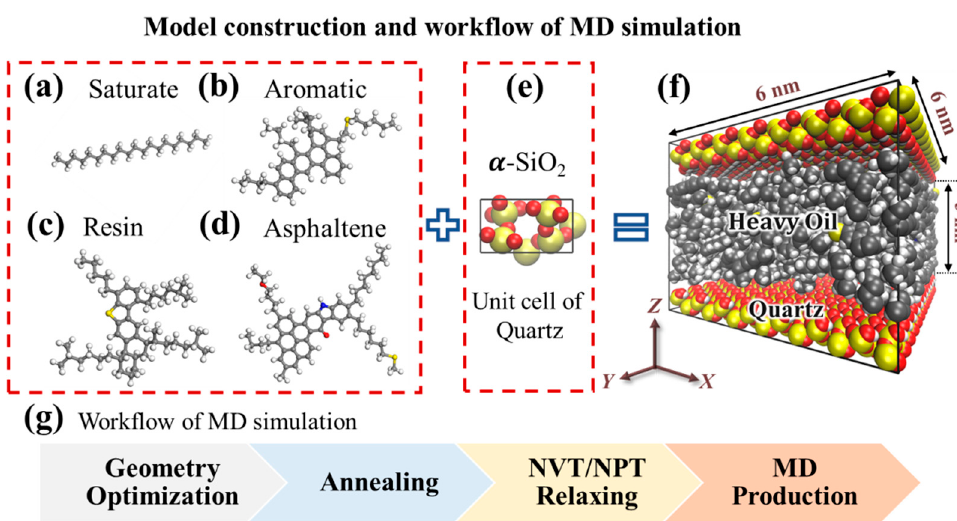
Figure 1. Model construction and workflow of MD simulation. ( a ) Saturate, ( b ) Aromatic, ( c ) Resin, and ( d ) Asphaltene molecular structures, ( e ) unit cell of alpha-quartz ( α -SiO 2 ) structure, ( f ) heavy oil/quartz nanopore model. ( g ) The workflow of MD simulation.